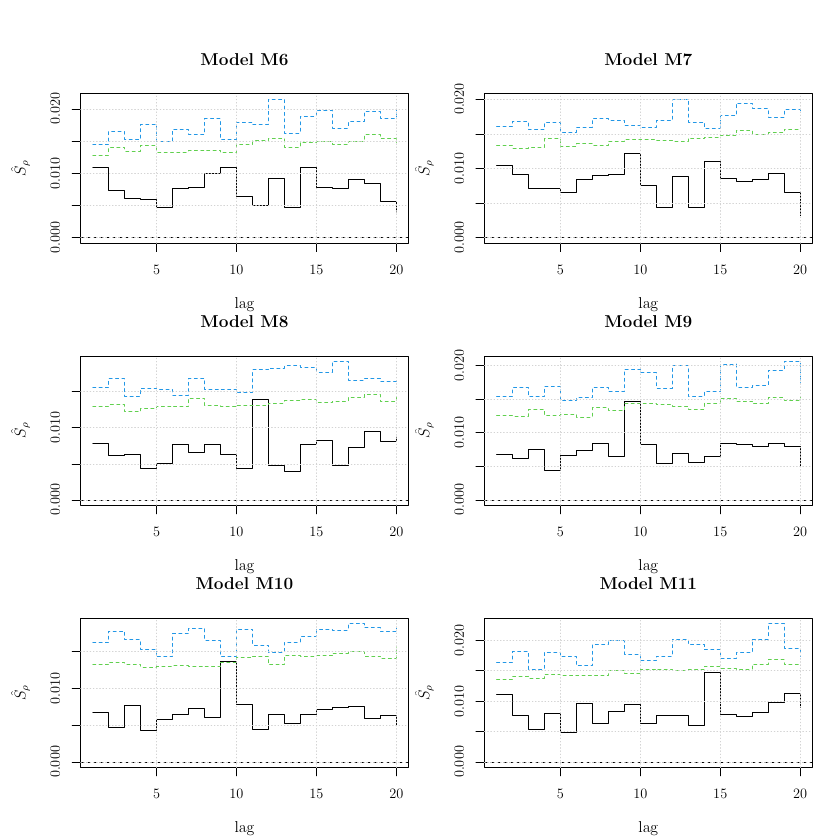
Figure 17 – Entropy measure S ρ computed on the residuals from the TARMA models M6 – M11 fit for the time series of the Canadian lynx. The confidence bands at 95% (green) and 99%(blue) correspond to the null hypothesis of serial